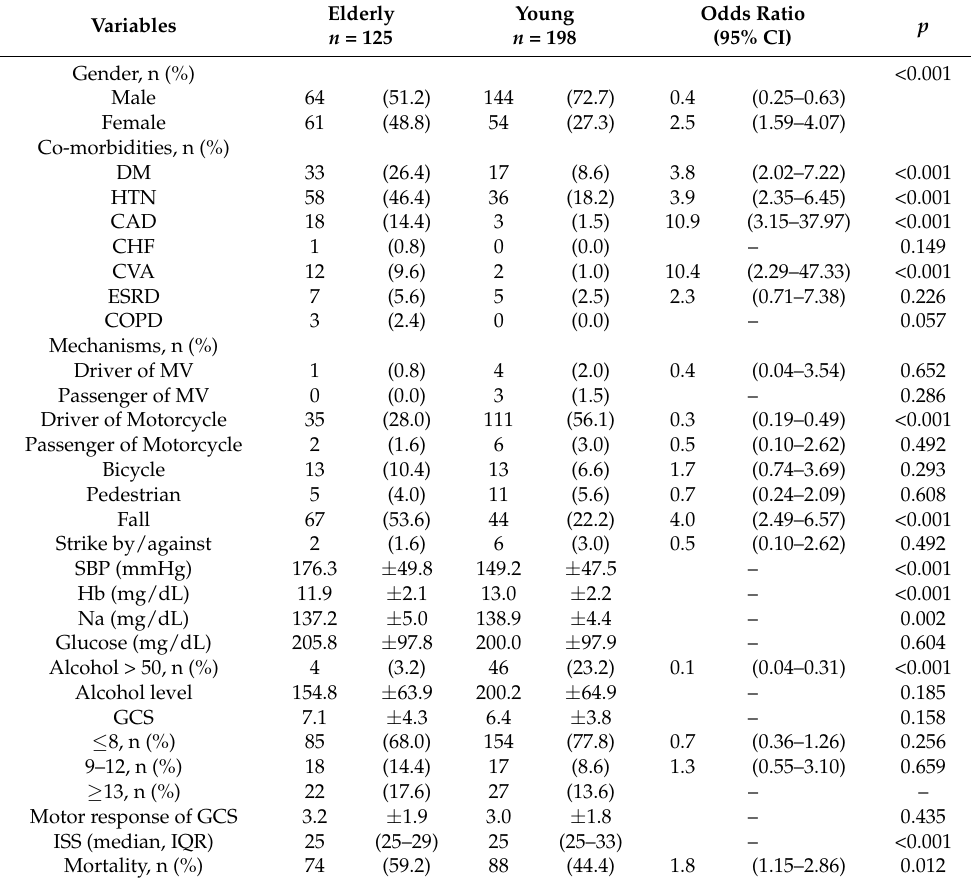
Table 3. Comparison of the characteristics and outcomes of the elderly and young adult patients with head AIS of